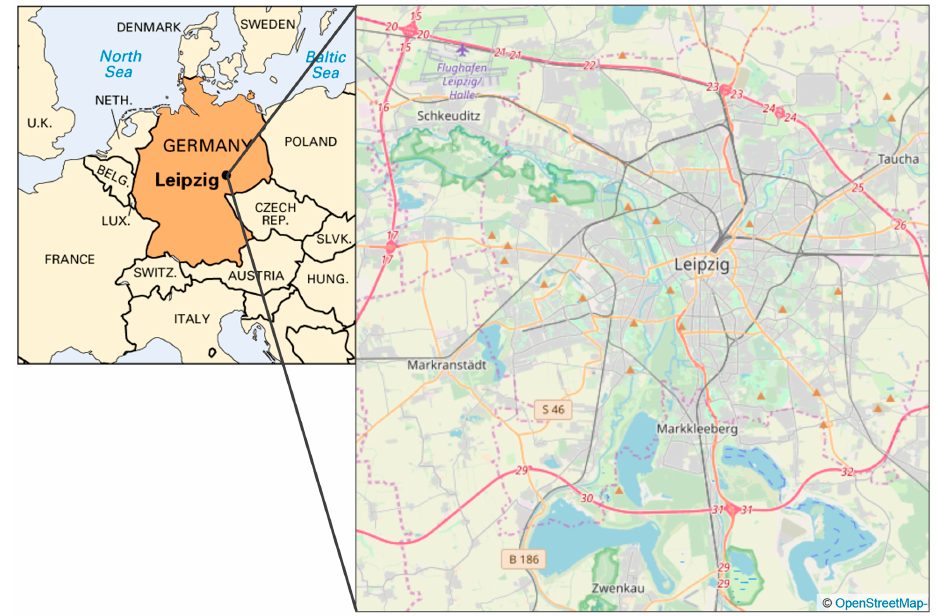
Figure 1. Map of Leipzig (data sources: OpenStreetMap; ArcGIS).